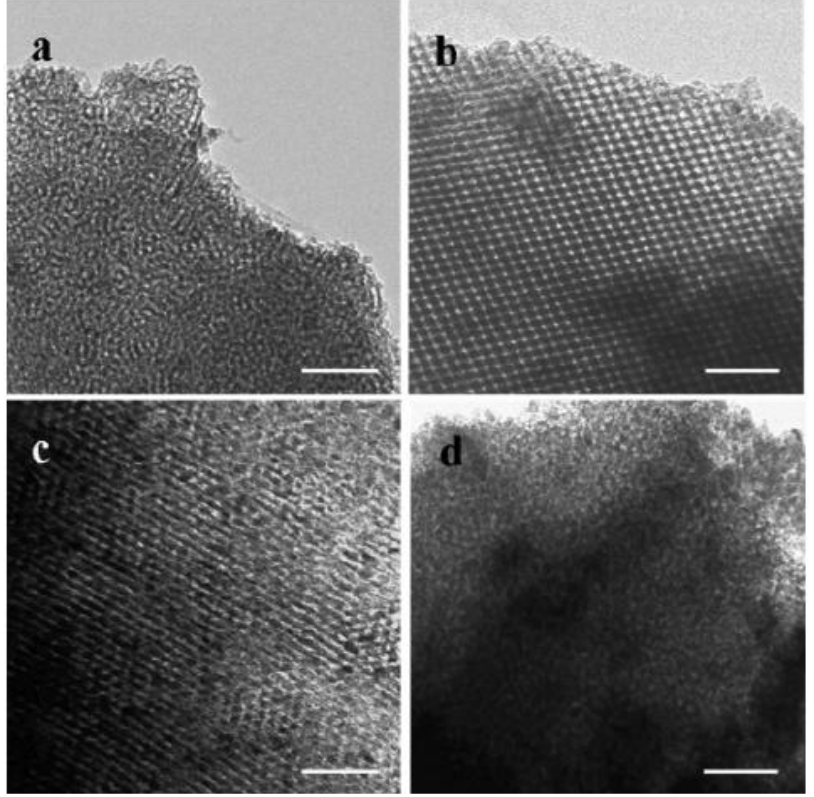
Figure 15. TEM images of TiO ( a ) 2.5/0; ( b ) 2.0/0.5; ( c ) 1.0/1.5; and ( d ) 0/2.5. Scale bar is 50 nm. Reprinted with permission from [84]. Copyright 2007 American Chemical Society.